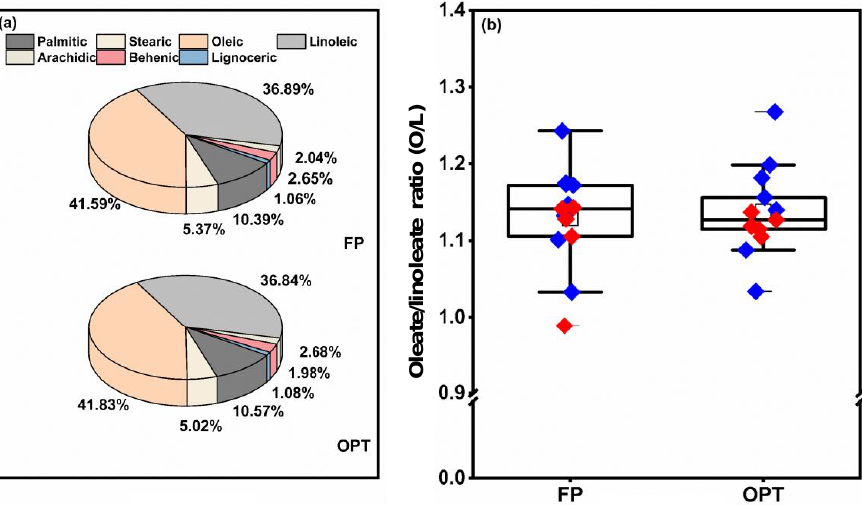
Figure 9. Fatty acid composition ( a ) and oleate/linoleate ratio (O/L, ( b )) of peanut kernels under different fertilization treatments. FP: farmers’ practice fertilization; OPT: optimized fertilization. For each box plot, the top, middle, and bottom solid lines of the box represent the 75% quantile, 50% quantile, and 25% quantile, respectively; the top and bottom horizontal lines outside the box represent the 90% quantile, and 10% quantile, respectively. The square inside the box represents the mean. Blue or red diamonds: data in 2020 or 2021.